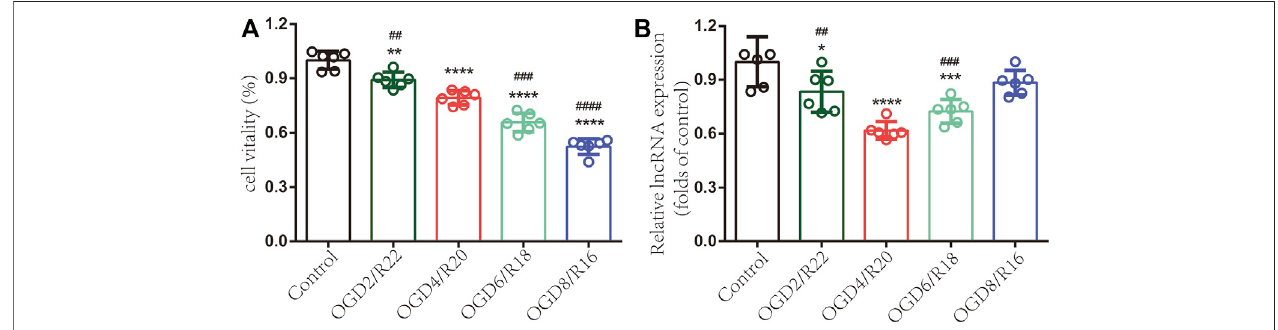
FIGURE 5 | LncRNA ENST00000530525 is downregulated in hCMEC/D3 cells under OGD/R condition. Cells were exposed to OGD for 2, 4, 6 or 8 h and reoxygenate for 22, 20, 18 or 16 h. Each bar represents a different OGD duration and reoxygenation time (e.g., OGD2/R22 represents 2 h of OGD and 22 h of reoxygenation). (A) The cell vitality worsened as the OGD time increased (B) LncRNAs highly downregulated under OGD4/R20 conditions. * p < 0.05, ** p < 0.01, **** p < 0.0001 (vs. control); ## p < 0.01, ### p < 0.001, #### p < 0.0001 (vs. OGD4/R20), n = 6, one-way ANOVA.